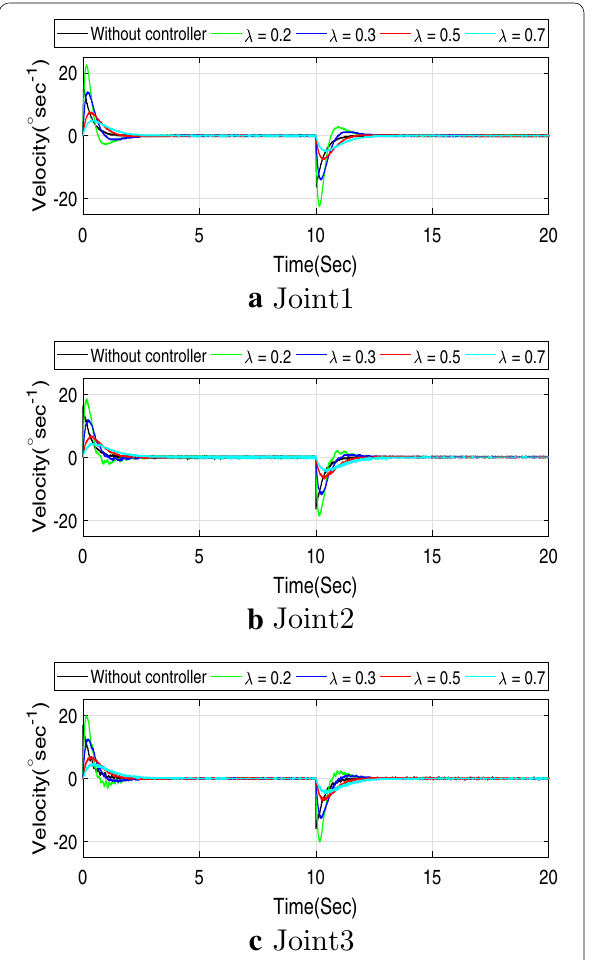
Fig. 11 Joint velocity profiles for varying (cid:31) . The figure shows the time variation of the joint velocities for (cid:31)